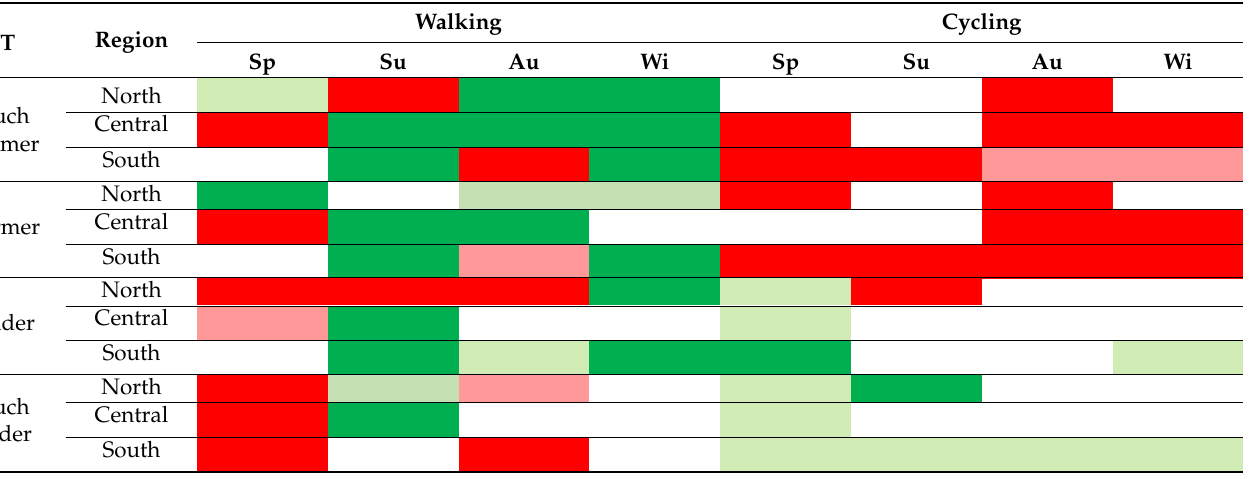
Table 3. Change direction of the active mobility mode (walking or cycling) depending on the categories of temperature deviation from normal conditions, differentiated according to seasons (Sp spring, Su summer, Au autumn, Wi winter) and three regions of Sweden (north, central, south); Color red: significant increase; Color light red: increase, but not statistically significant; Color green: significant decrease; Color light green: increase, but not statistically significant; Color white: no change (data base: